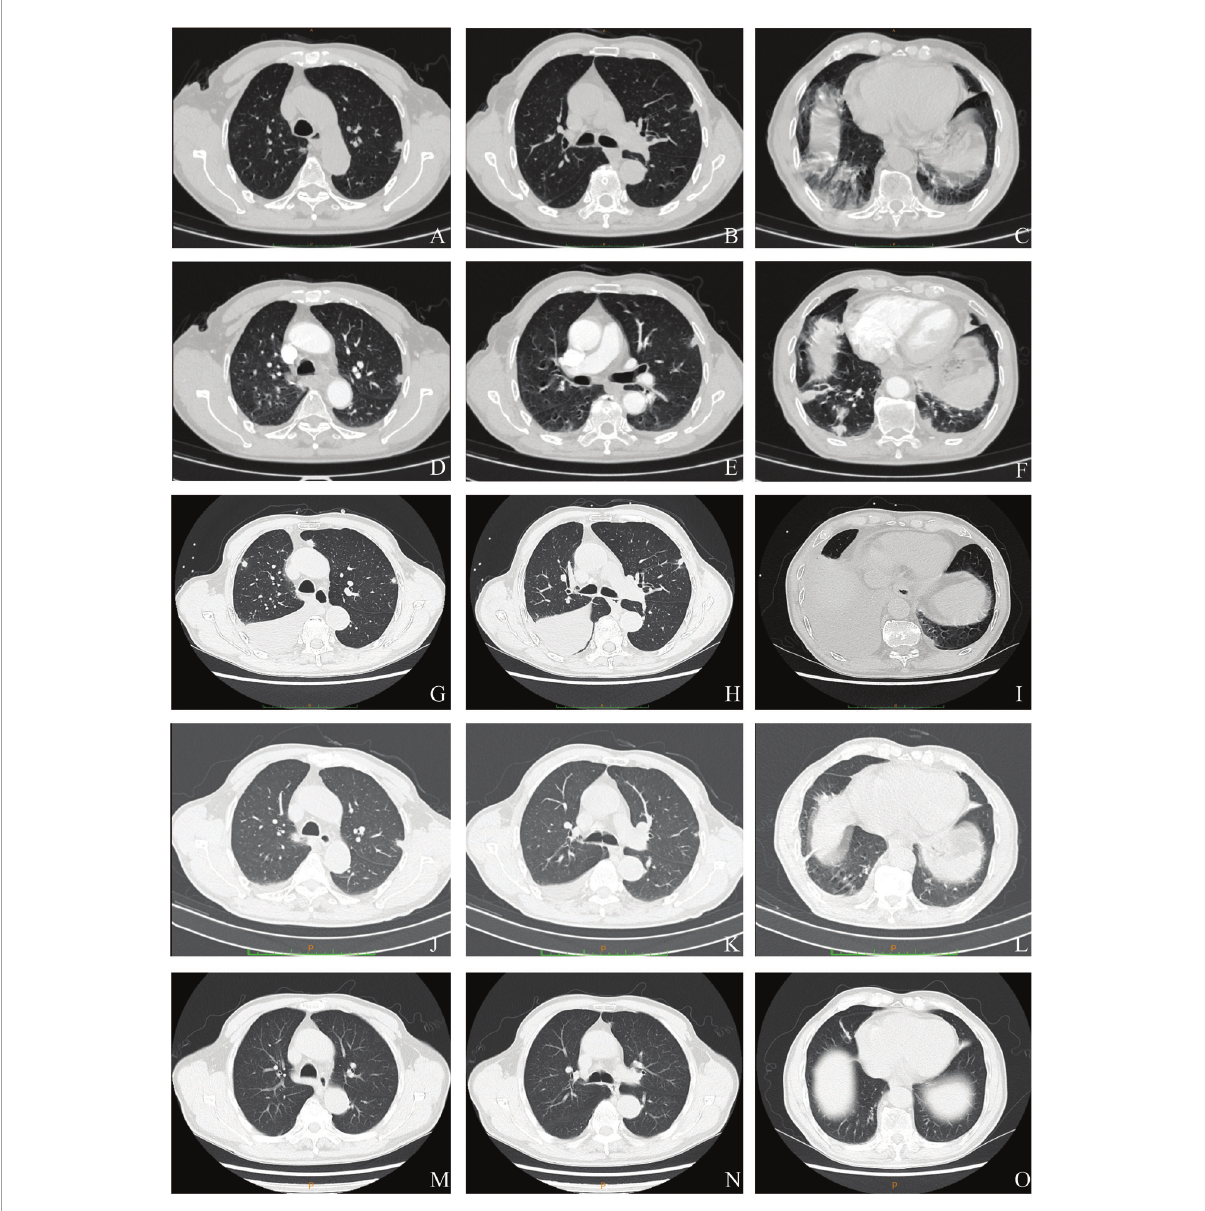
FIGURE2 Serial chest computed tomography (CT) scans of the patient with Parvimonas micra pneumonia. (A–C) The initial CT scan on 9 March 2022 (2 days after symptom onset) shows subpleural nodules in both lungs, some nodules with ground glass appearance, and a few exudative inflammatory lesions in both lower lungs. (D–F) A CT on the next day (10 March 2022) showed more nodules and exudative lesions in both lungs and some enlarged nodules. (G–I) A follow-up scan (21 March 2022) after treatment with amoxicillin clavulanate potassium